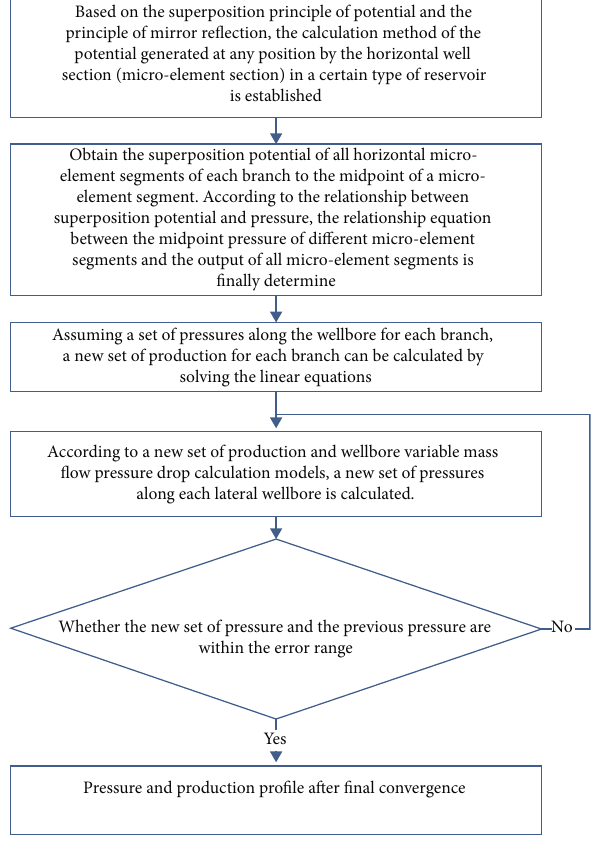
Figure 5: Flowchart of productivity calculation of fi shbone well.